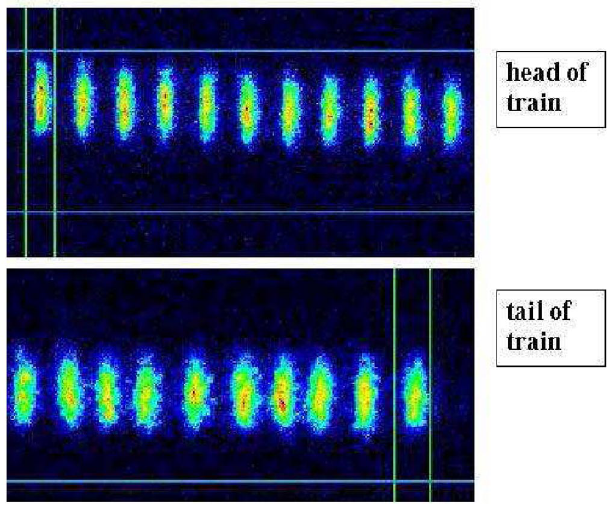
FIG. 15. (Color) Streak-camera measurement in dual-sweep mode of individual vertical beam sizes and their y - z correlation at KEKB [103]; the vertical axis is the time along the bunch, the horizontal axis the vertical direction; consecutive bunches are displayed, separated horizontally.